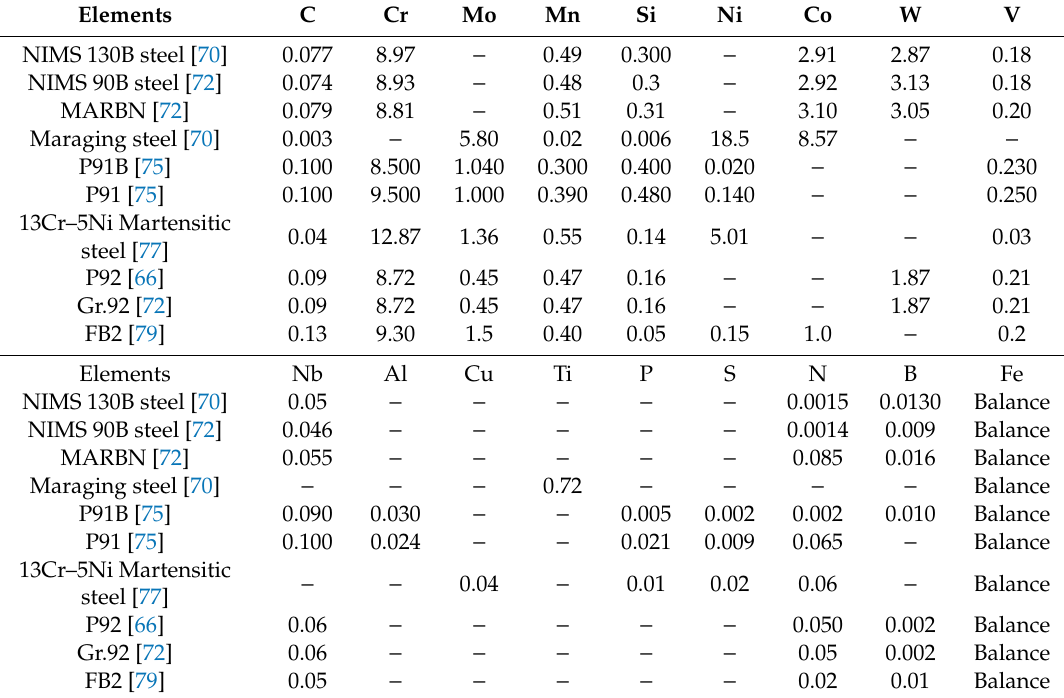
Table 2. The chemical compositions of steel grades reported in the present article (Wt-%).